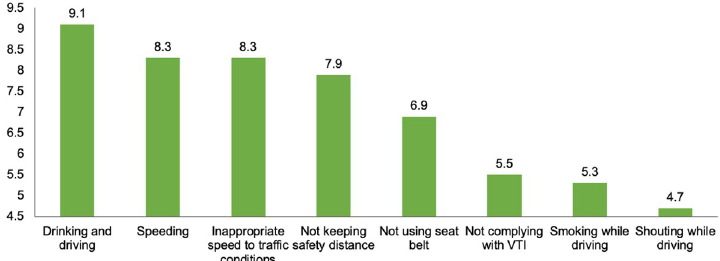
Fig 4. Perceived risk of having a road crash due to different driving